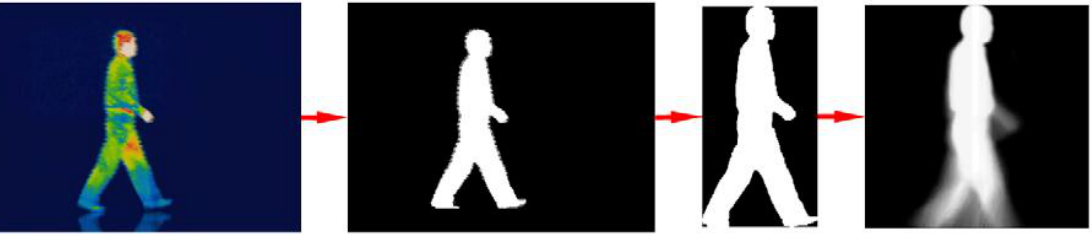
Figure 3. IRT image processing to extract the essential gait features. Reproduced with permission from Xue et al.